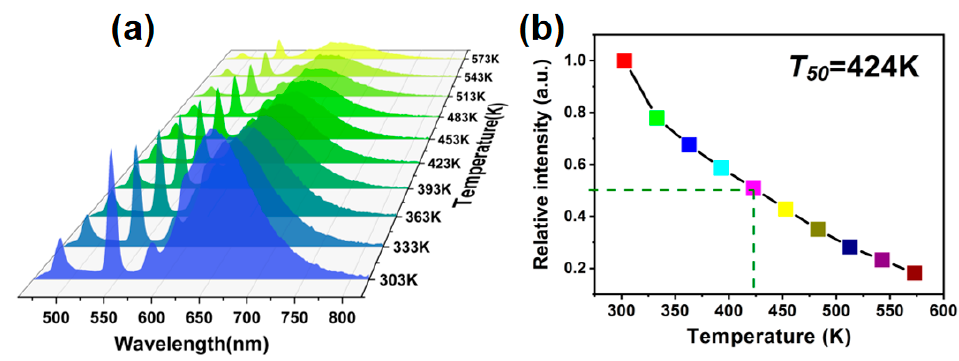
Figure 9. ( a ) Temperature-dependent PL spectra of the CTP:0.3Mn 2+ phosphors ranging from 303 to 573 K; and ( b ) the variation tendency of Tb 3+ and Mn 2+ ions from 303 to 573 K.